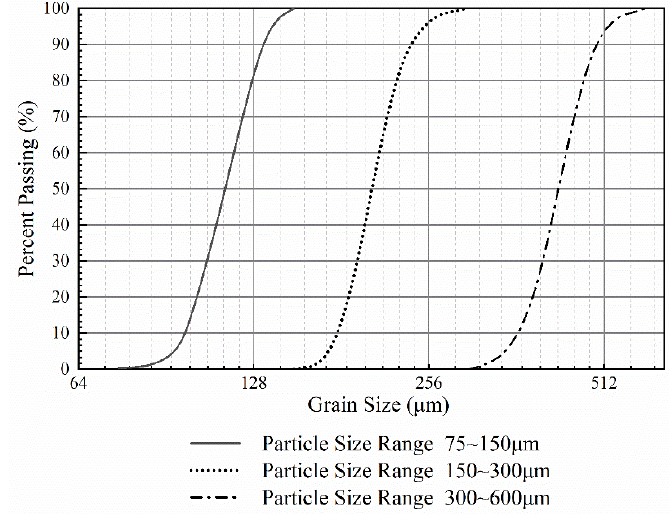
Figure 2. Particle size distribution of three kinds of sand specimen.